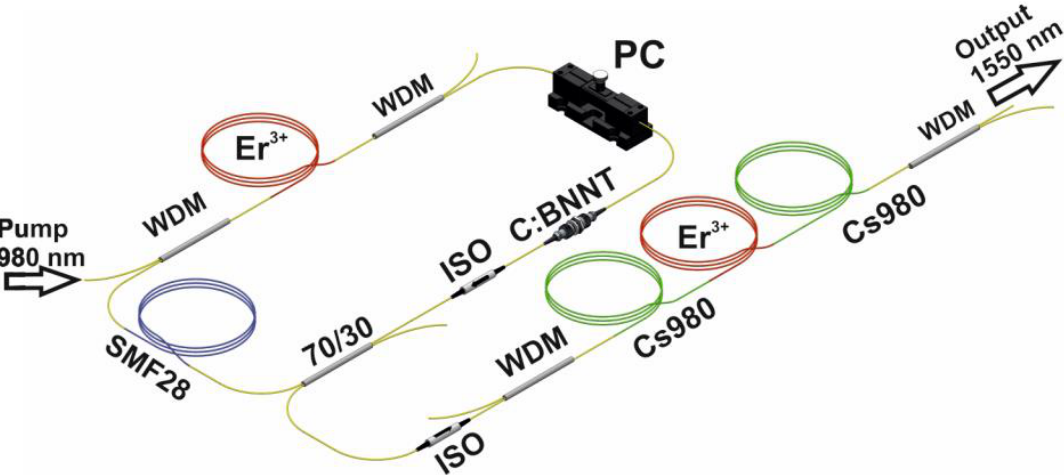
Figure 1. The experimental setup of the of the all-fiber EDF USP ring laser with C:BNNTs and linear erbium-doped fiber amplifier (EDFA) .